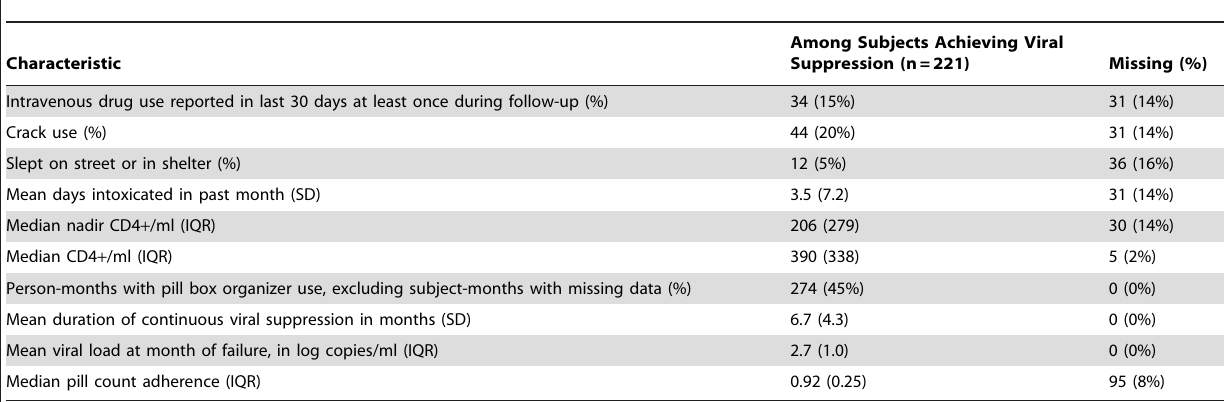
Table 2. Participant Characteristics During